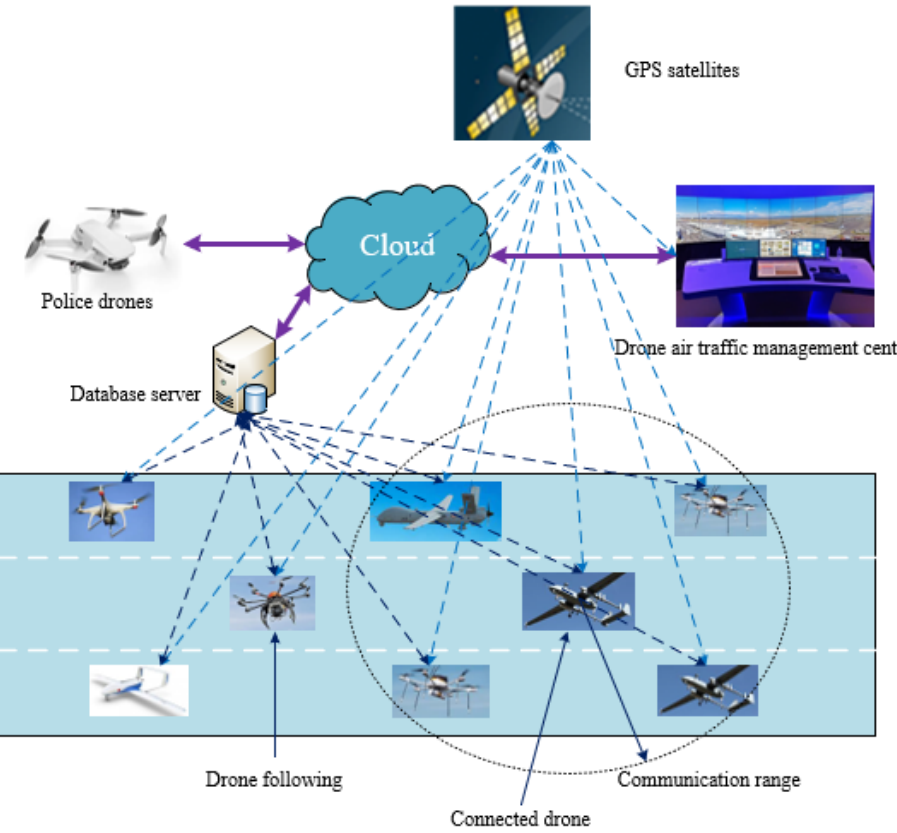
Figure 3. General concept and system layout of the proposed autonomous drone management system.